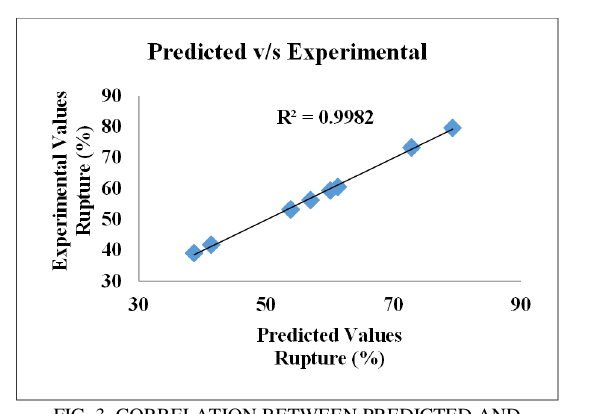
FIG. 3. CORRELATION BETWEEN PREDICTED AND EXPERIMENTAL RESULTS